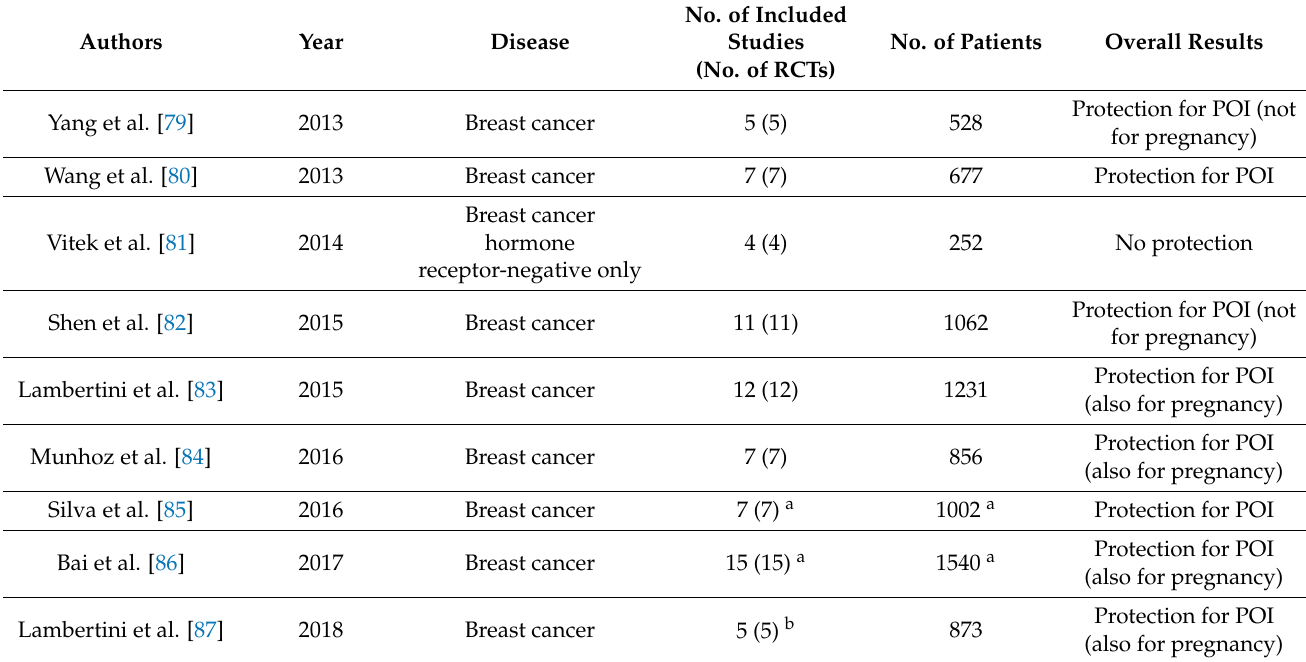
Table 2. Available meta-analyses evaluating temporary ovarian suppression with GnRHa during chemotherapy specifically and only in breast cancer